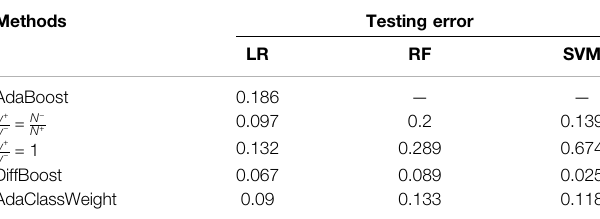
TABLE 3 | Testing error ϵ + test for the 39-bus power system